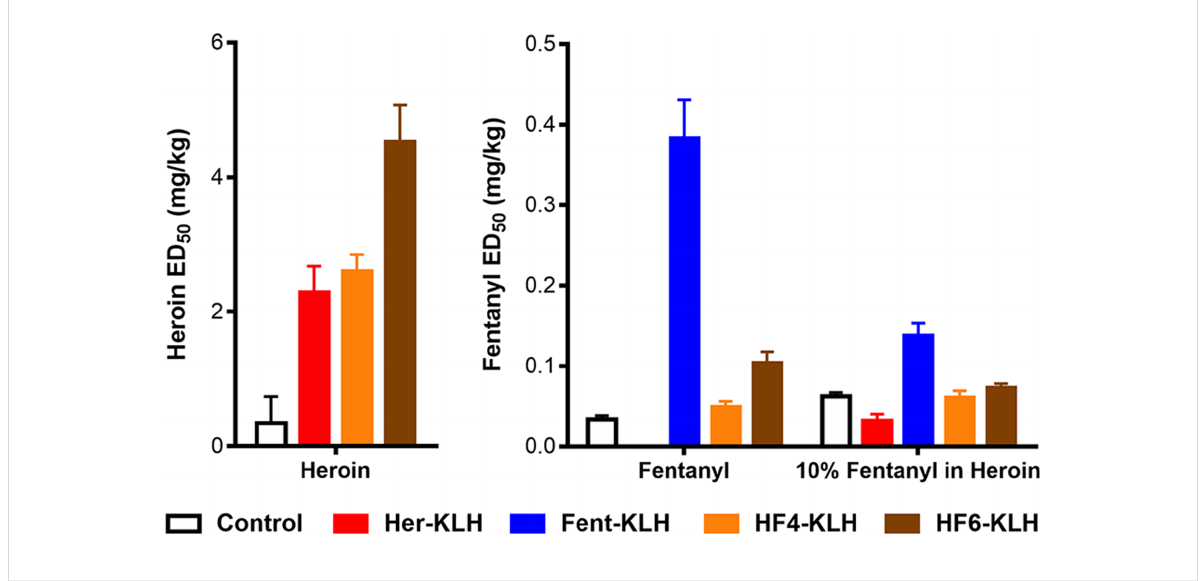
Figure 6: Summary of behavioral data for phenethyl-linked haptens HF-4 and HF-6 . Bars represent mean ± SEM.